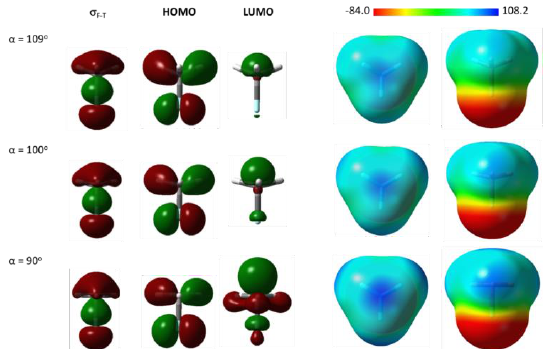
Figure 1. Chosen MOs and electrostatic potential (ESP) maps for 1 C with three different F-C-H angles (α). ESP maps are on the 0.001 density isosurface. The color scale is in kJ mol −1 . σ F-T corresponds to the bonding F-T σ orbital, irrespective of its position compared to other orbitals. The HOMO is doubly